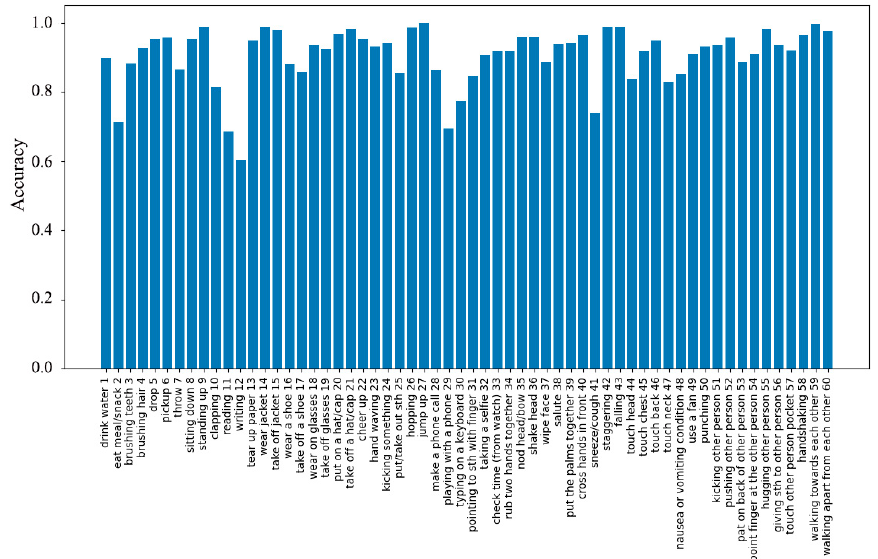
Figure 4. The recognition accuracy of 60 action classes on NTU RGB+D X-Sub.